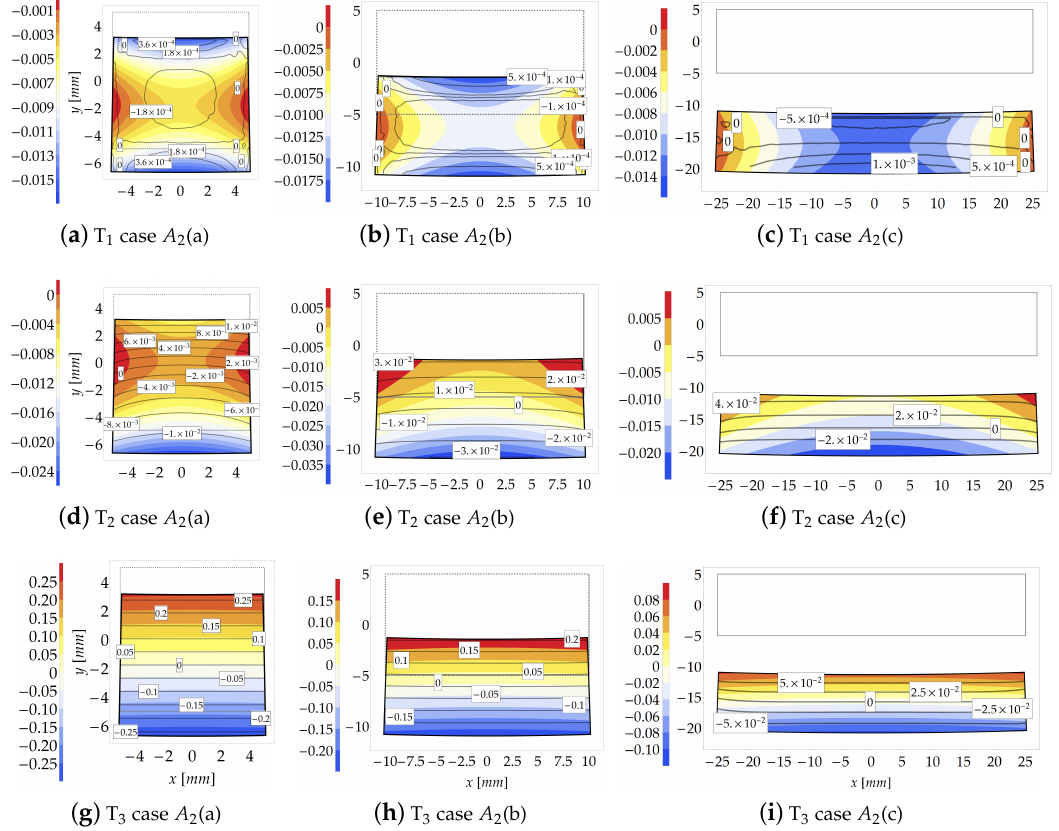
Figure 11. Study case A 2 at increment 3 ( µ = 100): Stresses comparison [MPa] between the theoretical model (contour plot) and FE model (isolines with boxed